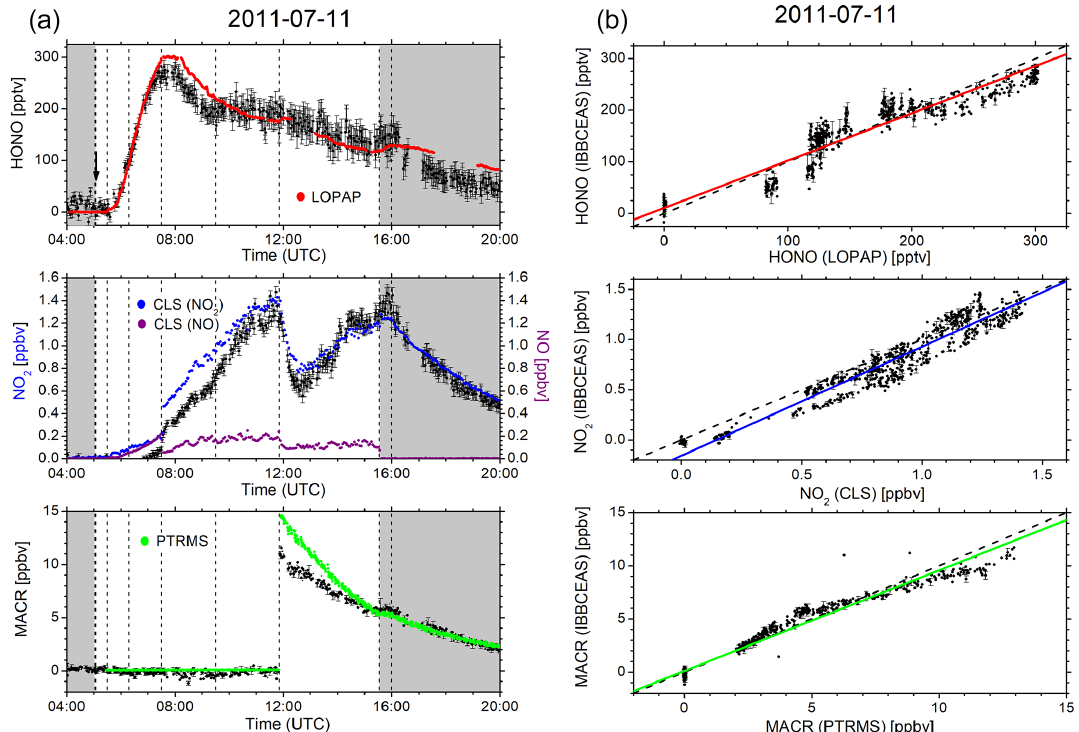
Figure 2. (a) Time-dependent HONO, NO 2 , and MACR mixing ratios measured by IBBCEAS (black trace) at SAPHIR on 11 July 2011. The NO mixing ratios (purple) measured by the CLS instrument are also shown. Dashed vertical lines indicate changes in the chamber conditions according to the experimental protocol: overnight flushing of chamber with zero air stopped (05:03UTC), roof opened (05:05UTC), humidi- fication started (05:30UTC), humidification ended (06:18UTC), 40ppbv O 3 (07:30UTC), 750ppbv CO (09:30UTC), MACR (11:51UTC), roof closed (15:33UTC), and flushing with zero air started (16:00UTC). IBBCEAS data taken in the near-UV region of the spectrum (352– 386nm) are compared to LOPAP (red), CLS (blue), and PTRMS (green) data. The vertical black arrow indicates the time when I 0 was measured (generally for 10min). (b) Correlation plots of two instruments being compared against IBBCEAS. The dashed line represents the identity, and the coloured solid lines are linear regressions to the data. Results are listed in Table